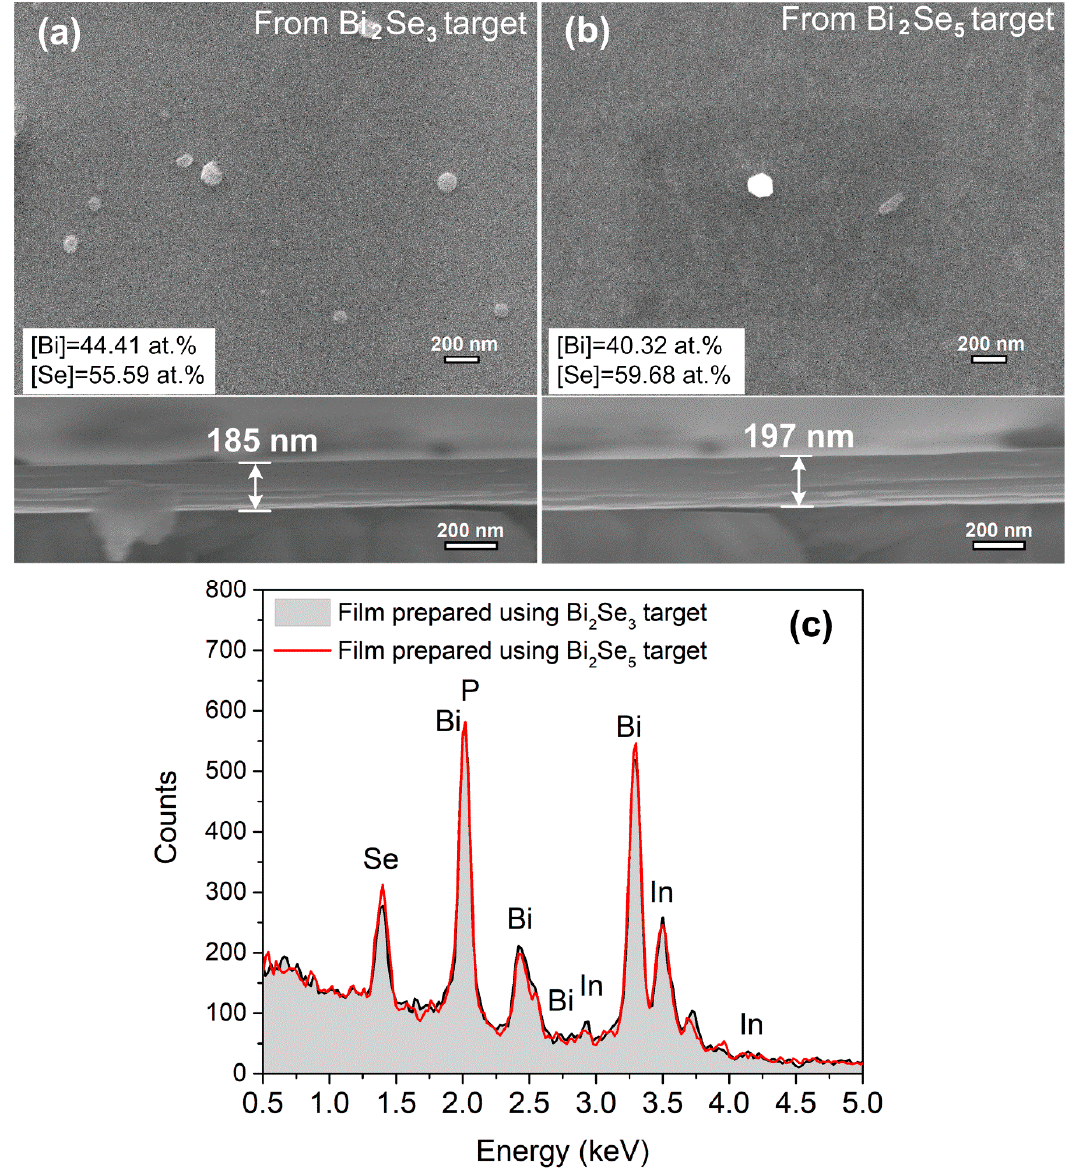
Figure 3. Top-view and cross-sectional SEM images of the Bi 2 Se 3 thin films deposited from ( a ) Bi 2 Se 3 target and ( b ) Bi 2 Se 5 target. ( c ) EDS spectra of the corresponding Bi 2 Se 3 thin films.